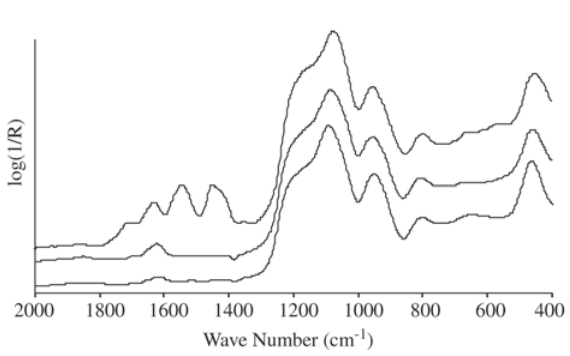
Figure 3. DRFTIR spectra of STB samples treated at 110 °C, 600 °C and 800 °C (top to